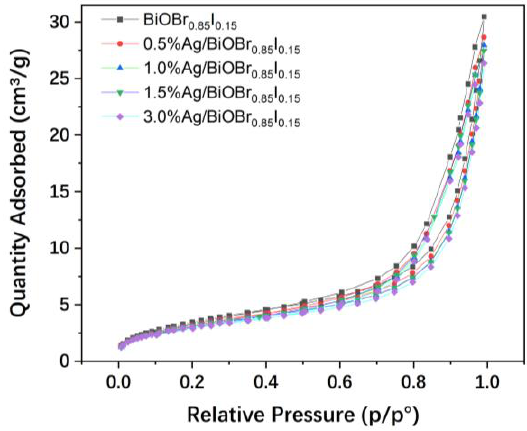
Figure 6. N 2 adsorption – desorption isotherms.